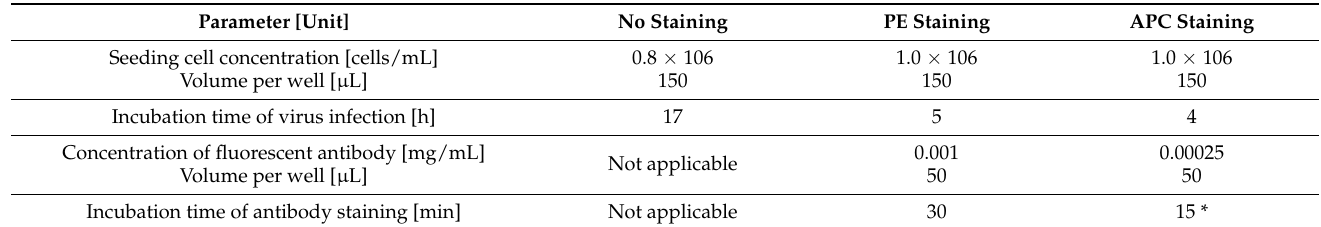
Table 1. Optimum method parameters determined for the flow-cytometry-based quantification of BVs after the infection of Sf9 cells in a 96-well format. The procedure without staining is only suitable for viruses expressing a fluorophore (e.g., GFP), whereas the staining procedure targets the gp64 surface protein, which is present on all BVs, independent of the